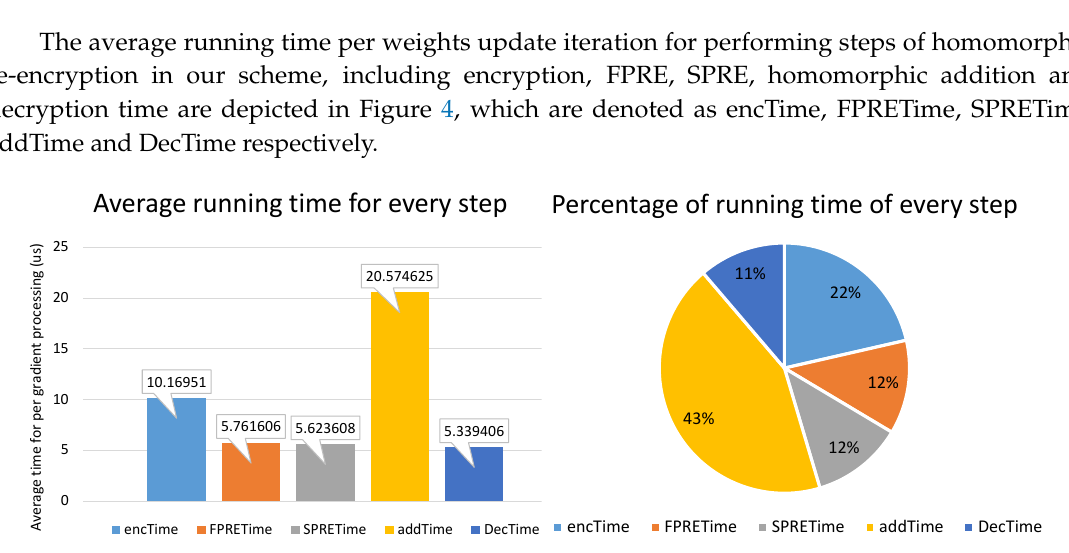
Figure 4. ( a ) Average running time for every step. ( b ) Percentage of running time for every